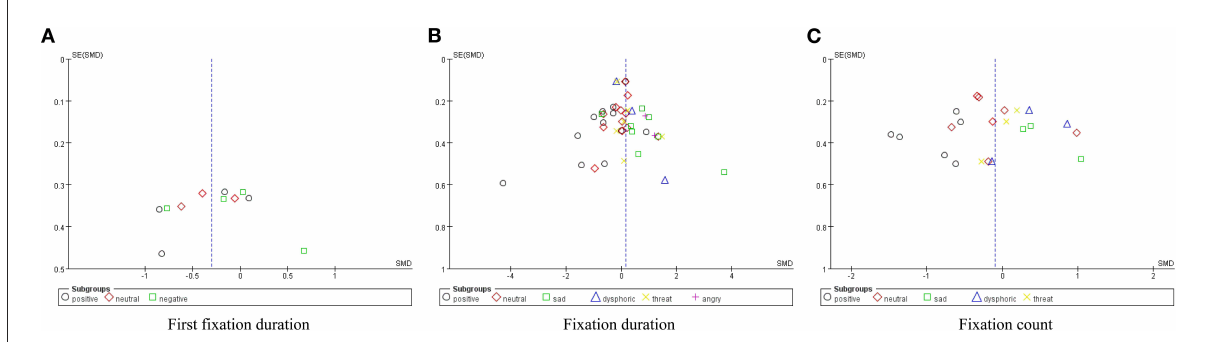
FIGURE2 Funnel plots of publication bias of first fixation duration (A) , fixation duration (B) , and fixation count (C) .